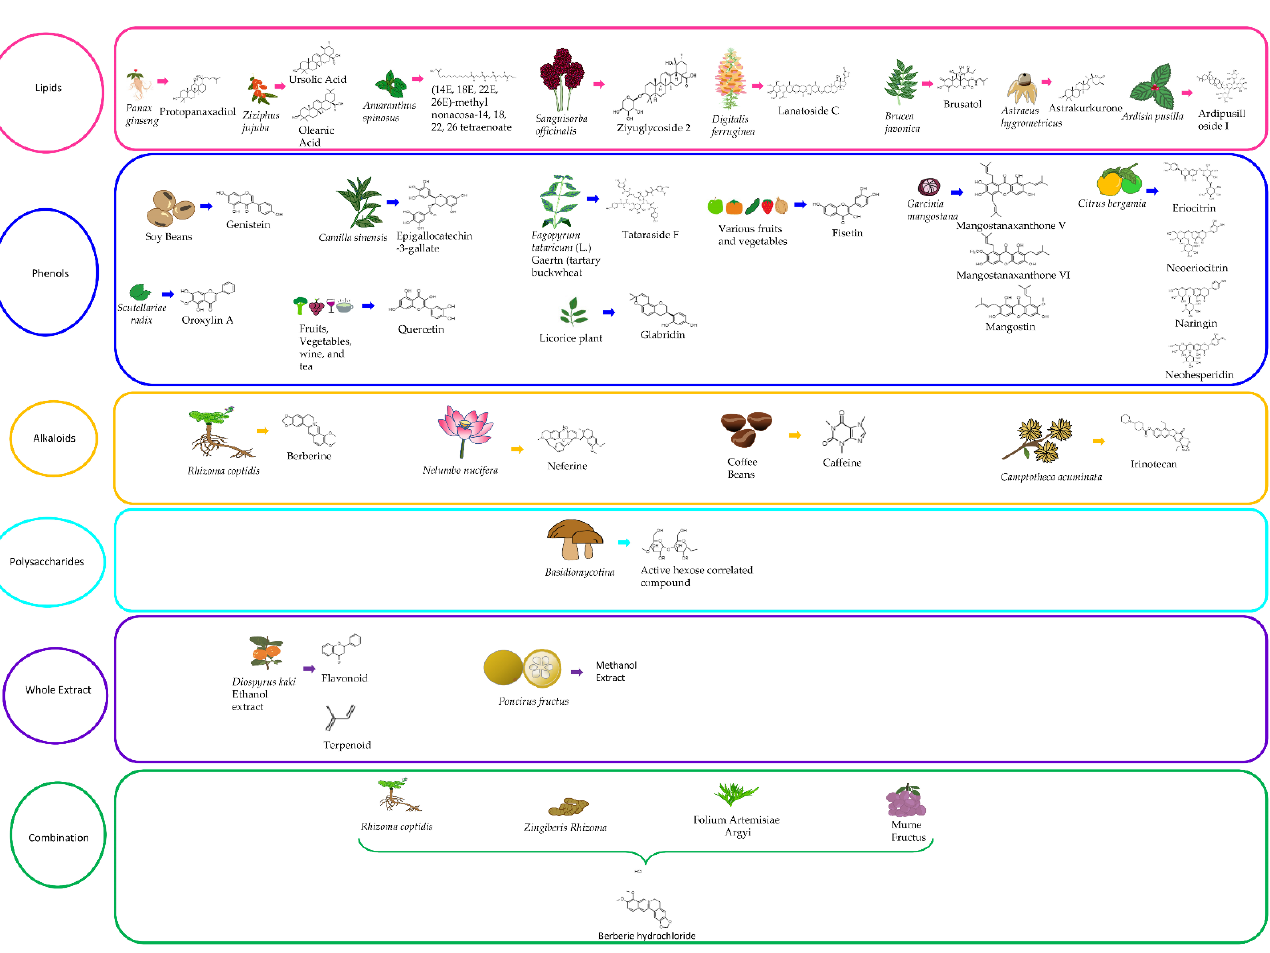
Figure 3. Phytochemical compounds against HCC fall into several categories: lipids, polyphenols, alkaloids, whole extracts, and phytochemical